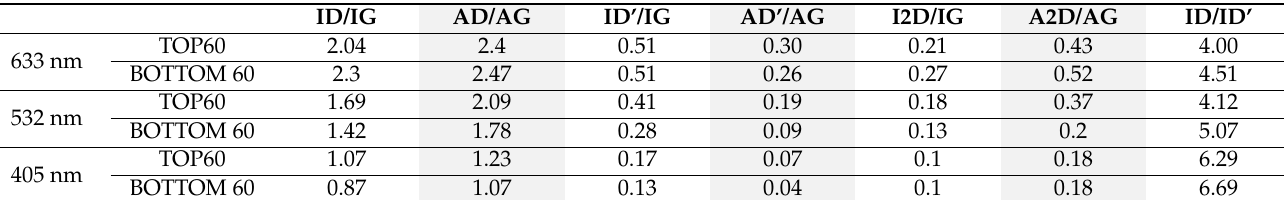
Table 5. Intensity and area ratios of the relevant Raman